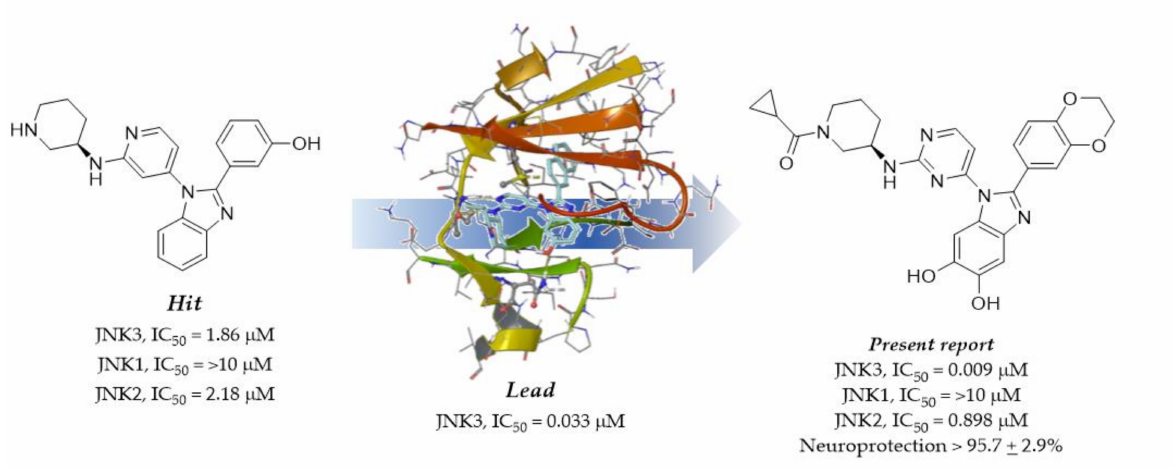
Figure 2. Discovery of JNK3 selective inhibitors from previous lead based on co-crystal